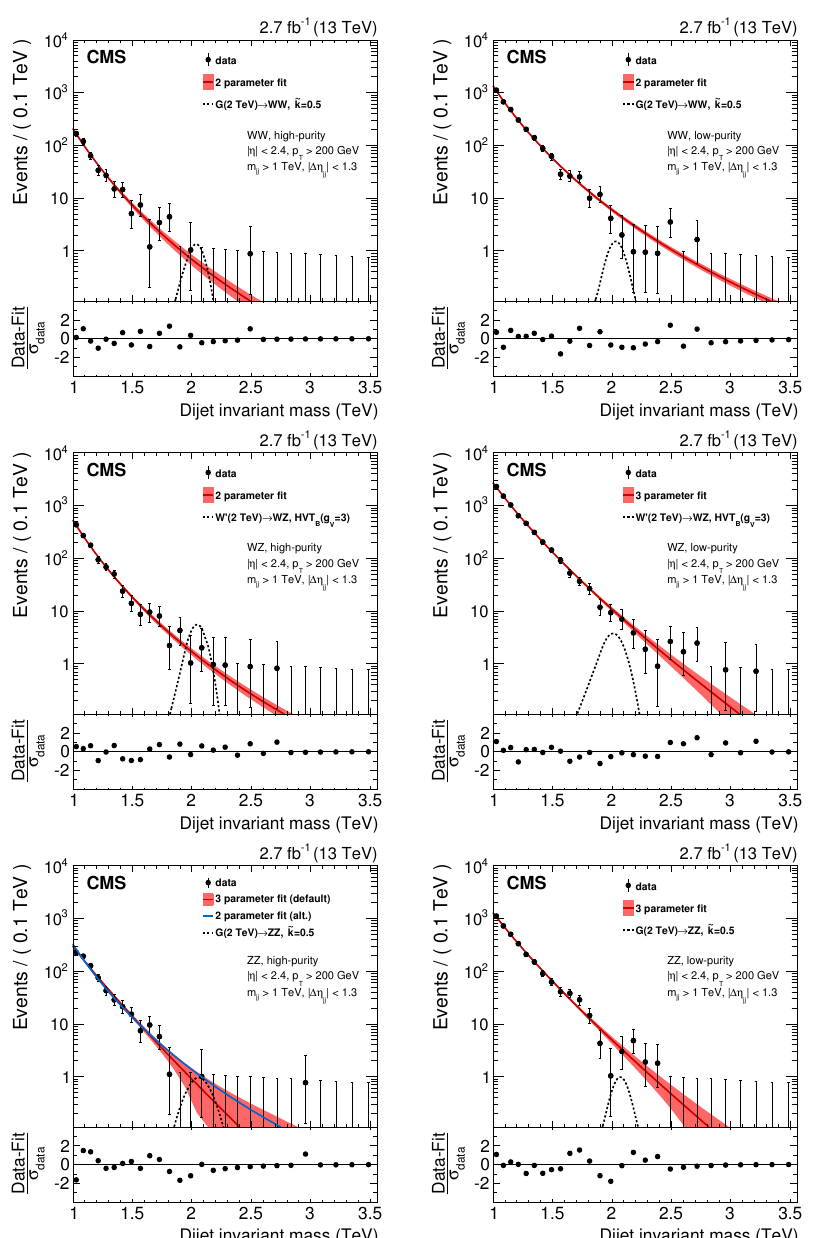
Figure 1 . Final m jj distributions for the dijet analysis in six signal regions. The high-purity (on the left) and the low-purity (on the right) categories are shown for the WW (top row), WZ (central row), and ZZ (bottom row) m jet regions. The solid curve represents a background-only (cid:12)t to the data distribution, where the (cid:12)lled red area corresponds to the (cid:6) 1 standard deviation statistical un- certainties of the (cid:12)t. The data are represented by the black points. For the ZZ high-purity category (bottom left), we also show the background-only (cid:12)t using the two-parameter functional form (blue solid line), for comparison. Signal benchmarks for a mass of 2 TeV are also shown with black dashed lines. In the lower panel of each plot, the bin-by-bin (cid:12)t residuals, ( N data (cid:0) N (cid:12)t ) =(cid:27) data , are shown.